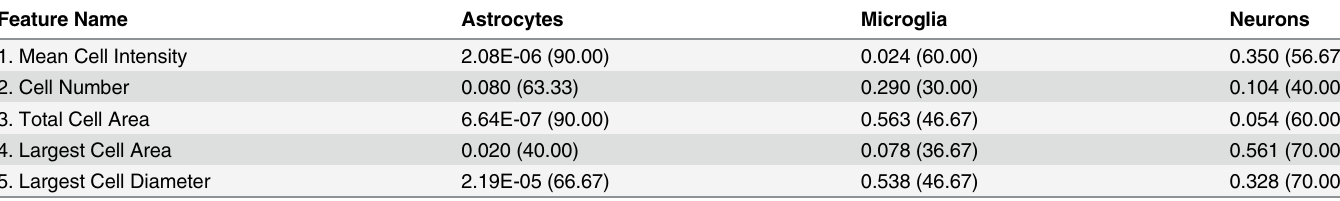
Table 4. The P values and prediction accuracies (%) of the neuronal features for astrocytes, microglia, and